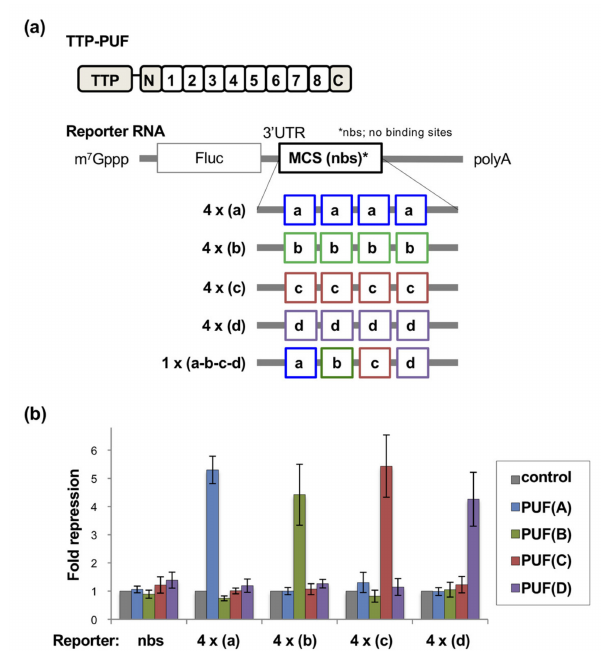
Figure 3. Specific binding of engineered PUF proteins to target RNAs in living cells. ( a ) Schematic representation of TTP-PUF proteins and reporter RNAs. TTP-PUF expression plasmids and